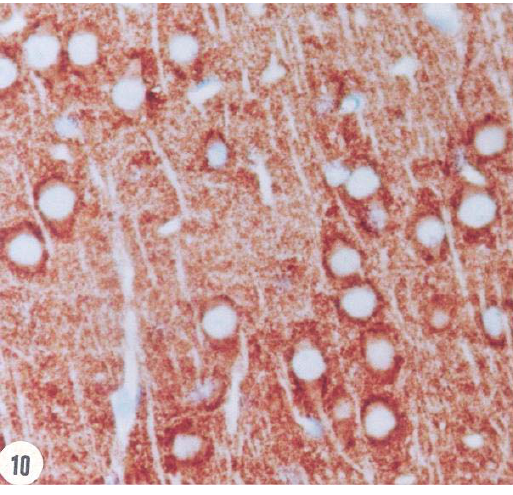
Figure 10. Increased SYN immunoreactivity 48 hr after low dose envenoming.